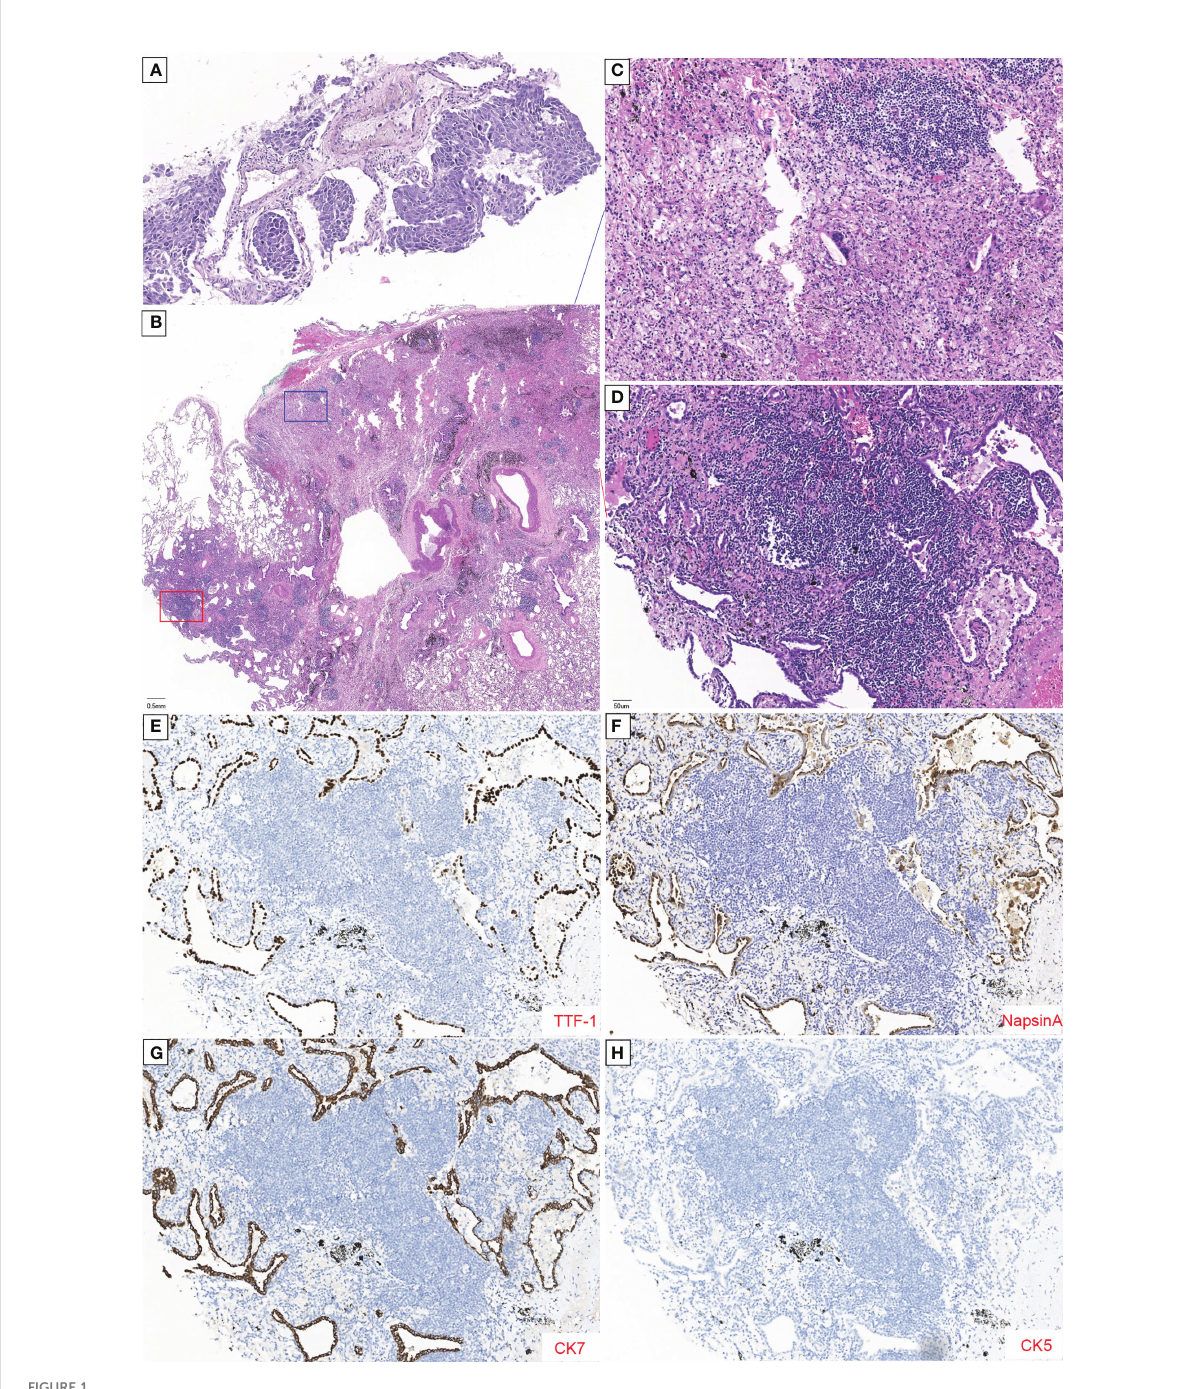
FIGURE 1 Histopathology of tumor with major pathological response (MPR) to neoadjuvant savolitinib. (A) High-power magni fi cation (×200) shows tumor cell nests without in fl ammatory cell in fi ltration and initially diagnosed as a poorly differentiated carcinoma. (B) Low-power magni fi cation (×20) shows that only 5% of this tumor was viable with 95% showing fi brosis and chronic in fl ammation without necrosis tissue in the pathology of postoperative samples by H&E staining. (C, D) Enlargement of the blue and red boxes in (B) . (C) H&E staining image shows numerous foam cells, multinucleated giant cells, and cholesterol crystals. No viable tumor was seen. (D) Higher power magni fi cation shows the amount of in fl ammatory cell in fi ltration and the formation of lymphoid follicular, with the acinar type of tumor cells growing with adherence. Immunohistochemical (IHC) reveals that tumor cells were positive for TTF-1 (E) , Napsin A (F) , and CK7 (G) and negative for CK5 (H) . The scale length is 1